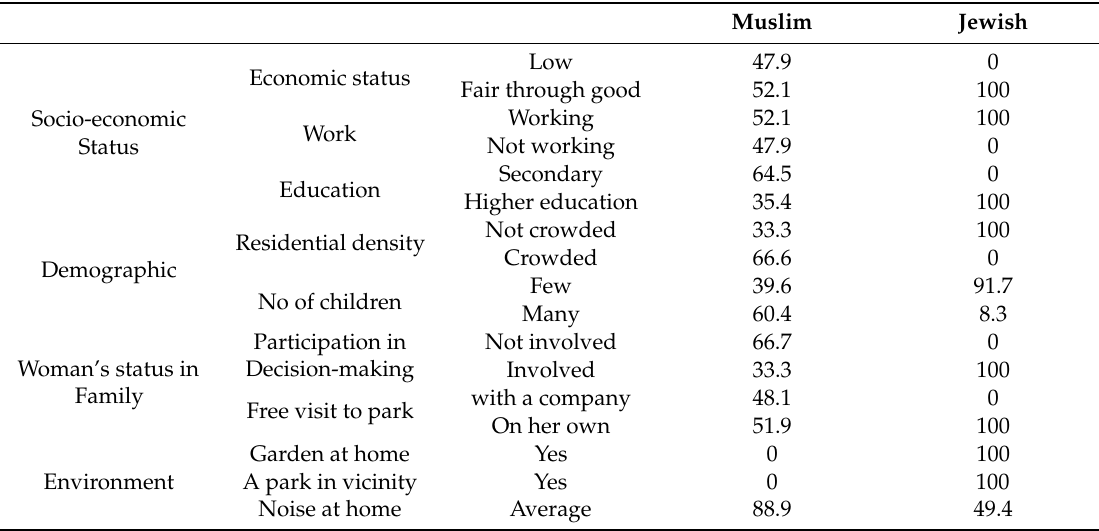
Table 2. Distribution of Muslim ( n = 48) and Jewish mothers ( n = 24), n = (%).